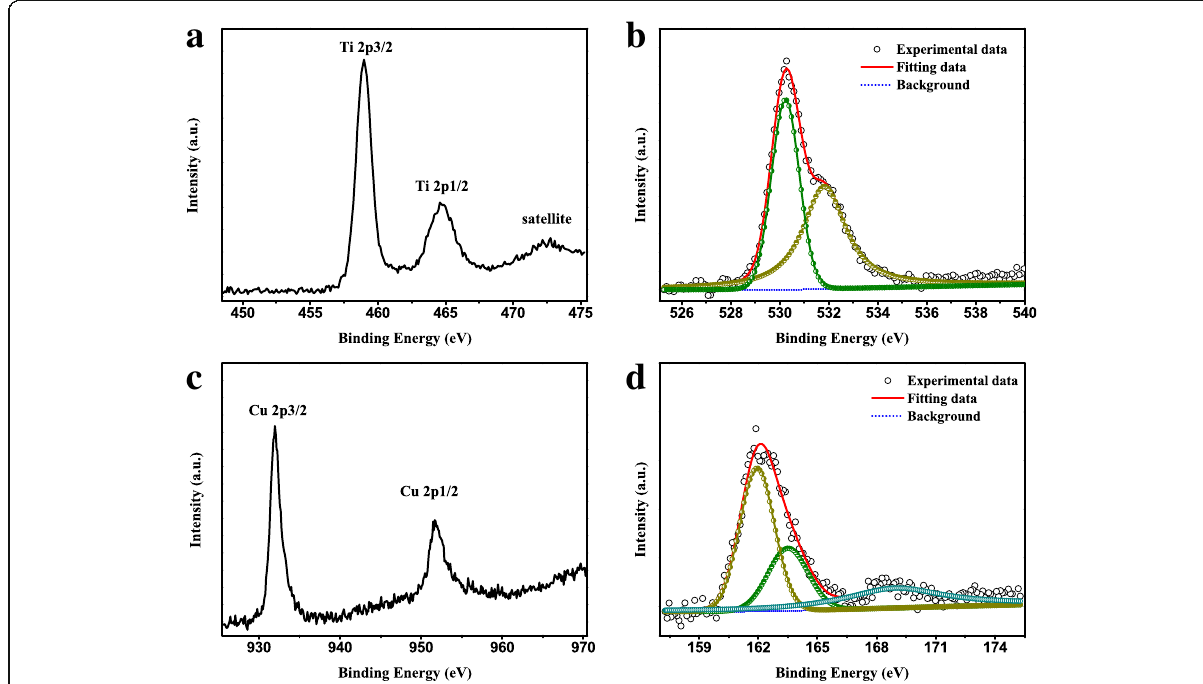
Fig. 4 High-resolution XPS spectra of a Ti 2p, b O 1s, c Cu 2p, and d S 2p in Cu 1